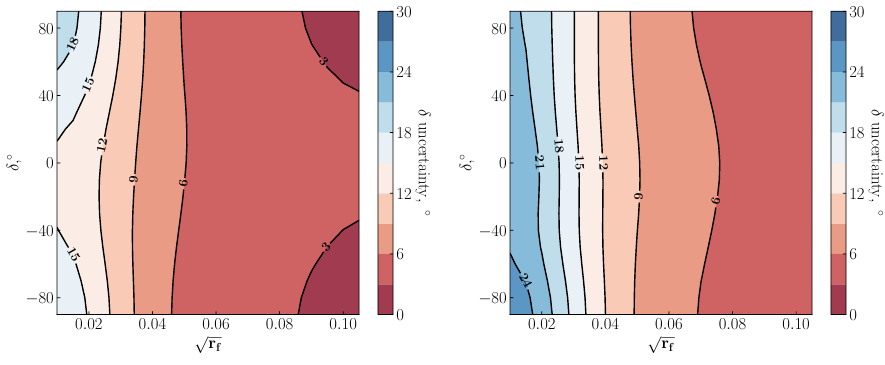
Figure 4 . Obtained uncertainties for the strong phase difference — δ in D + decay (left) and in D 0 decay (right)